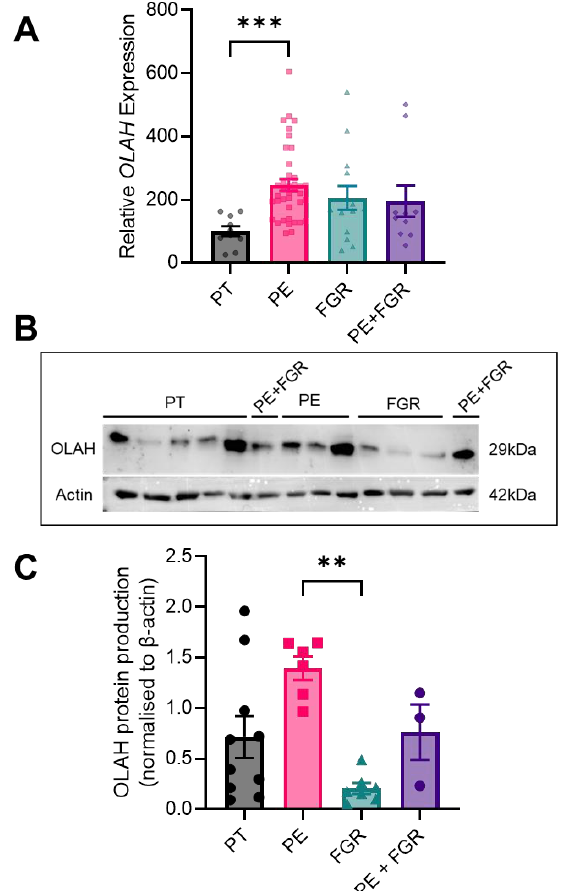
Figure 3. OLAH mRNA expression and protein production in placental tissue collected from cases of preterm preeclampsia and fetal growth restriction compared to preterm control. ( A ) Relative OLAH mRNA expression assessed via qPCR, ( B ) representative western blot image of OLAH protein production, and ( C ) densitometric analysis of western blot data. OLAH mRNA expression was significantly elevated in placental tissue collected from pregnancies complicated by preterm preeclampsia (PE) compared to preterm control (PT), but not altered in placenta from pregnancies complicated by fetal growth restriction (FGR), and both fetal growth restriction and preeclampsia (PE + FGR) ( A ). Densitometric analysis demonstrated that OLAH protein was not significantly altered in any group compared to preterm control tissue ( C ). However, OLAH protein was significantly reduced in placenta collected from pregnancies complicated by fetal growth restriction compared to samples collected from cases of preeclampsia ( C ). Data presented as mean ± SEM. Gene expression: PT n = 10, PE n = 39, FGR n = 14, PE + FGR n = 10. Protein production: PT n = 10, PE n = 6, FGR n = 7, PE + FGR n = 3. ** p < 0.01, *** p < 0.001. Full western blot images presented in Supplementary Figure S1.